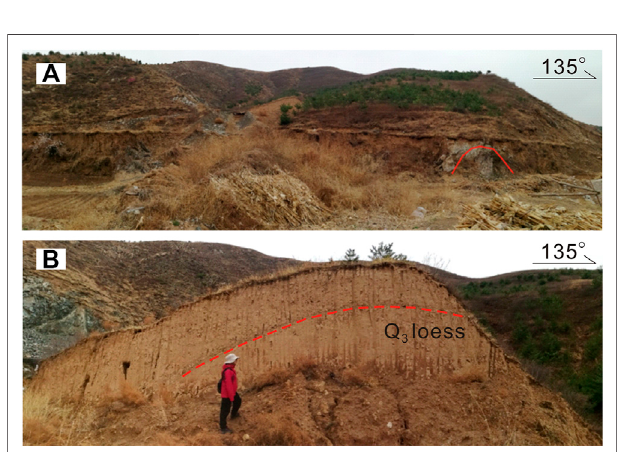
FIGURE 3 | NNE-striking normal fault and NW-striking fault (refer to Figure 1 , N 10 , for the location). (A) Panorama of the entire outcrop and an anticline developed in pre-Cenozoic formations. (B) Folded loess pro fi le along the NW-striking fault, indicating the axis ofcompression in NW direction.